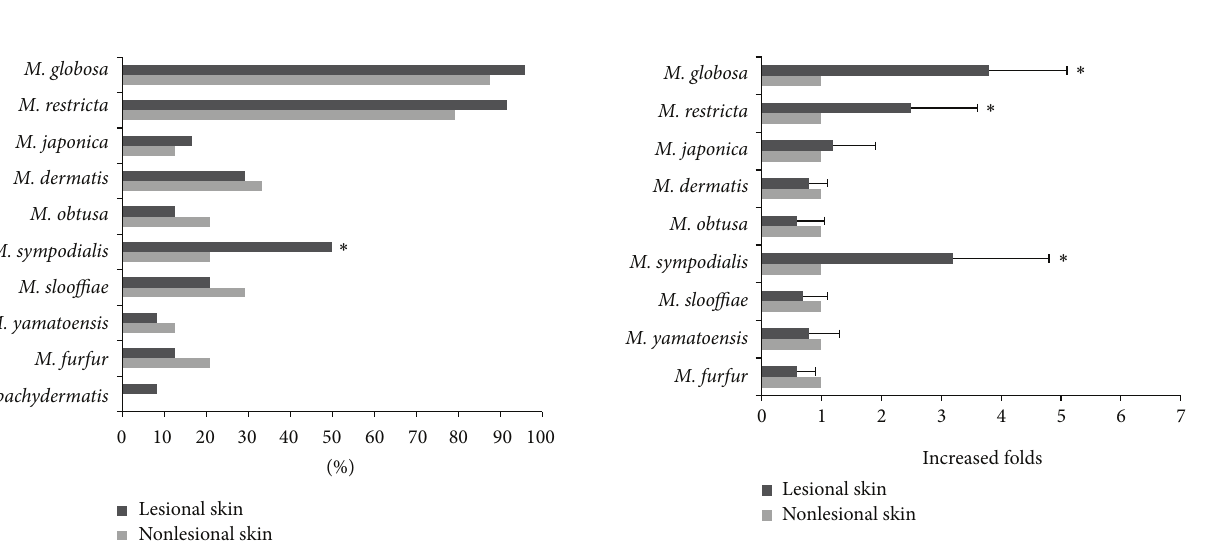
Figure 2: Malassezia species detection rates in the lesional and nonlesional skin of the 24 patients. ∗ 𝑃 < 0.05 , nonlesional skin versus lesional skin.